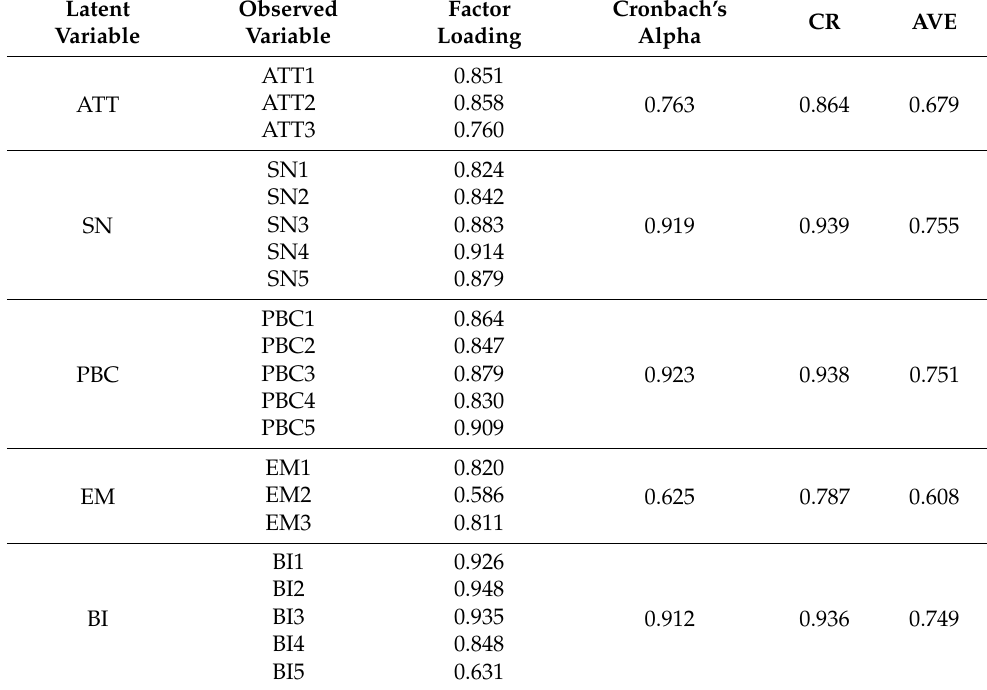
Table 3. Confirmatory factor analysis of variables.